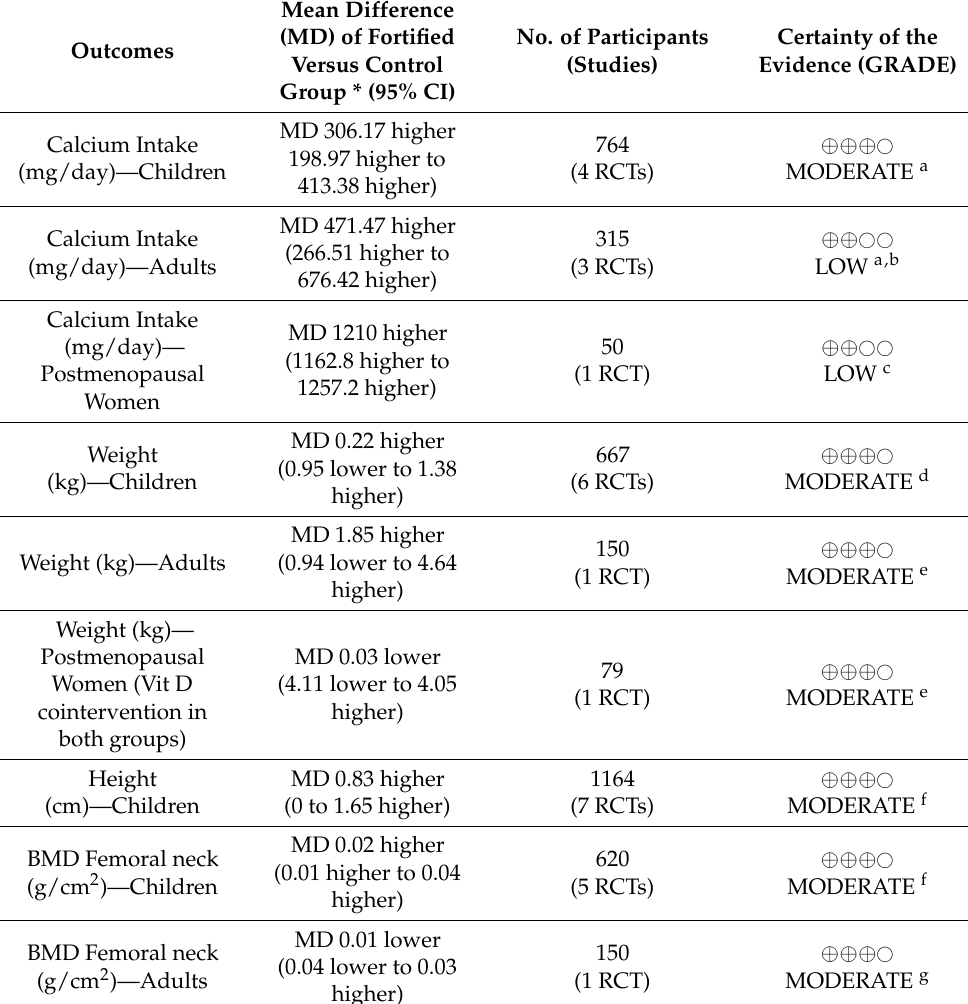
Table 2. Summary of findings of calcium fortification (+minerals/other) by population